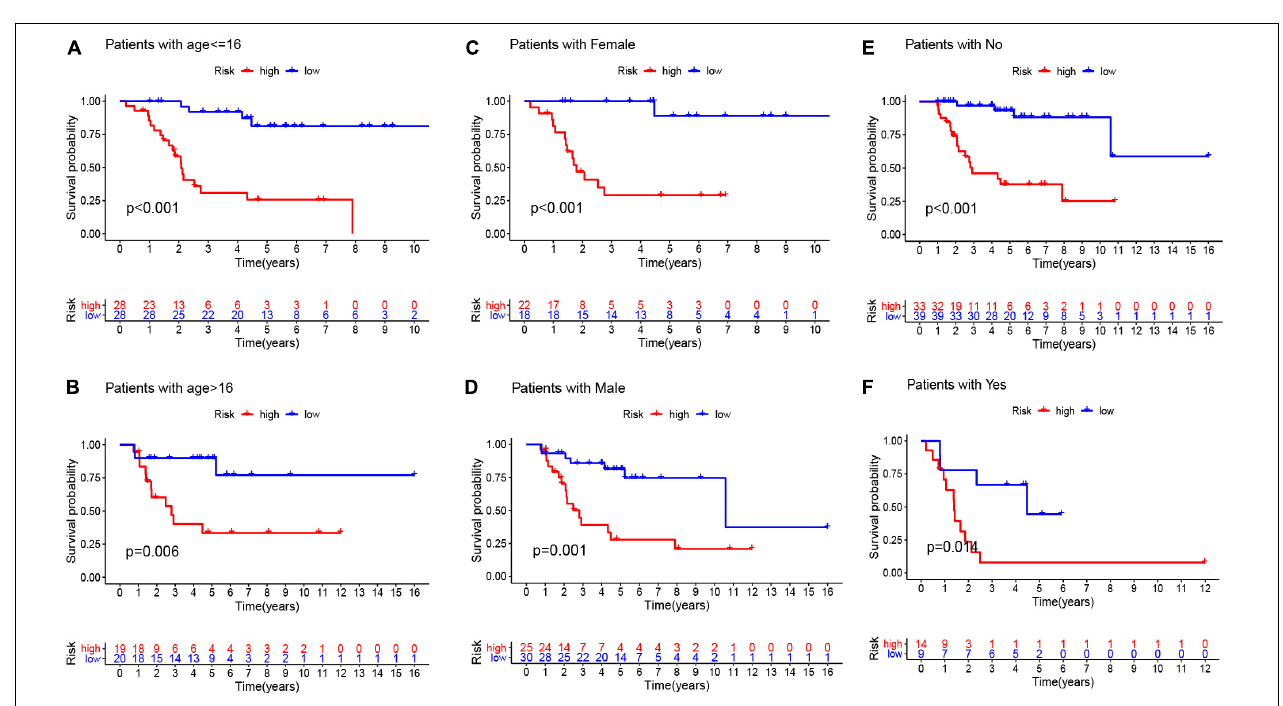
FIGURE 6 | The K-M curves for the two groups (high risk vs. low risk) assigned by clinical factors, comprising age (A,B) , gender (C,D) , and metastasis (E,F) .